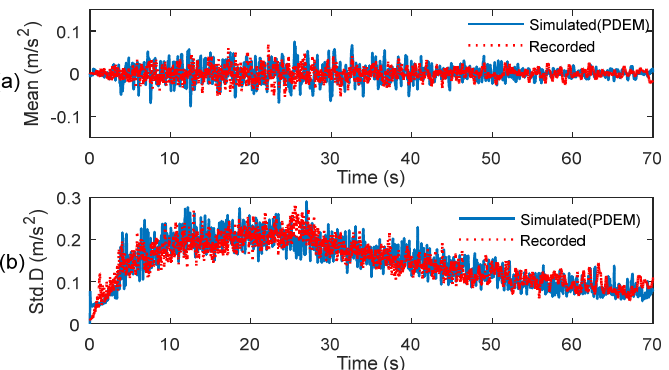
Figure 4. Comparison of simulated and recorded seismic ground motions. ( a ) mean; ( b ) standard deviation.